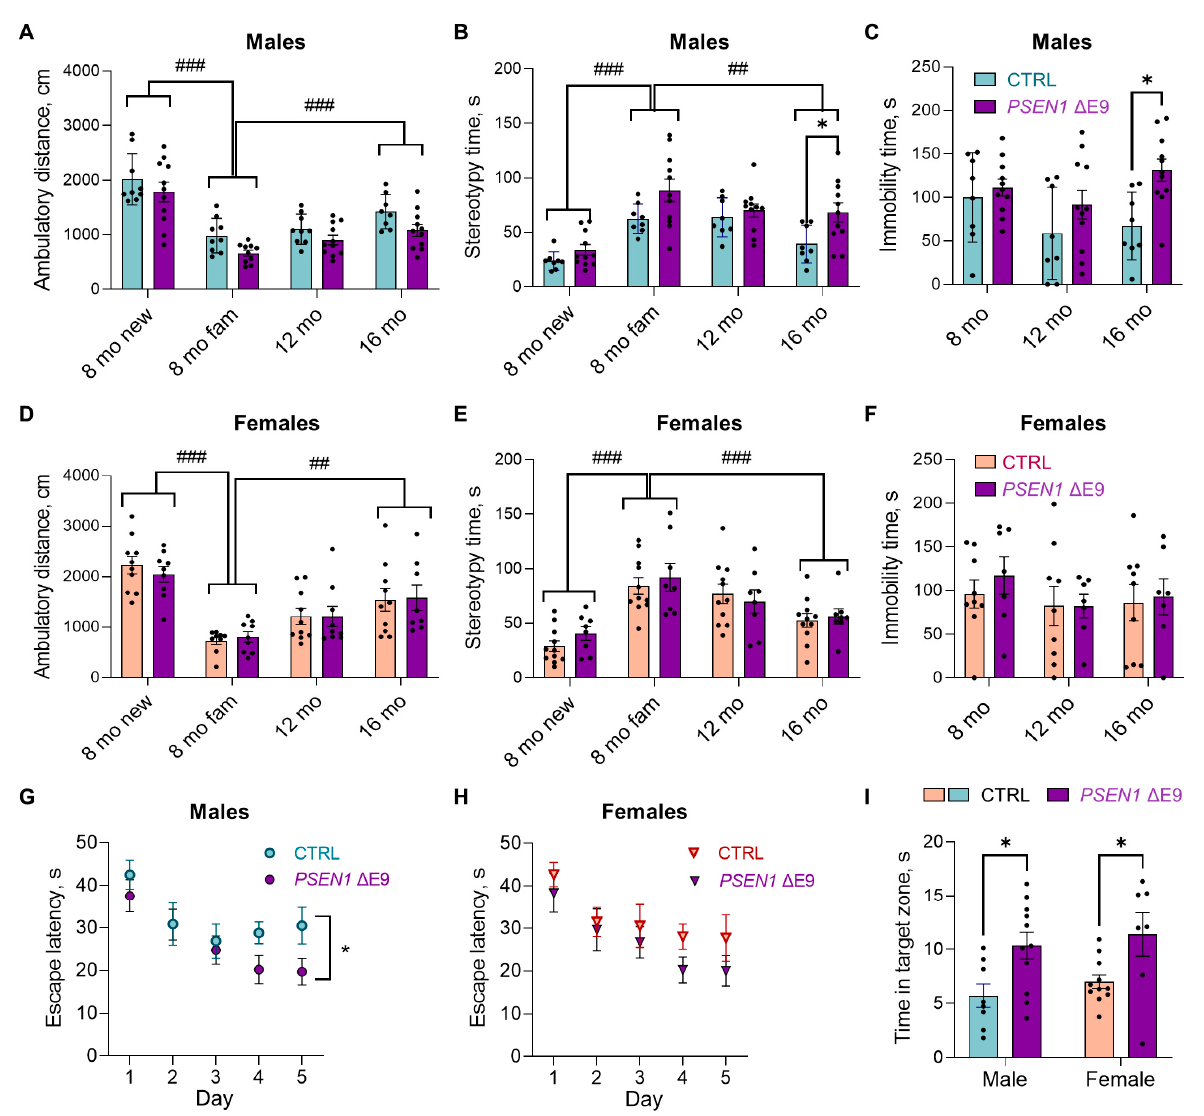
Figure 2. PSEN1 ∆ E9 mutation in human glial progenitors induced behavioral changes in 16-month- old mice. ( A , B , D , E ) Total distance traveled (cm) ( A , D ) and stereotypy time (s) ( B , E ) during a 10-min spontaneous exploration in the TruScan device at the ages of 8, 12, and 16 months in male ( A , B ) and female ( D , E ) mice. At the age of 8 months, the mice were exposed to the TruScan environment twice: first when it was a completely new environment (8-month new) and second when it was already a familiar environment (8-month fam). Purple bars indicate PSEN1 Δ E9 glia-transplanted mice, blue bars indicate CTRL-transplanted males, and salmon CTRL-transplanted females; dots represent values obtained from individual animals. ( C , F ) Immobility (floating) time (s) recorded during the last 4 min of a 6-min forced swim test. ( G , H ) Escape latency (s) to the submerged platform in Morris swim task (watermaze). ( I ) Time spent at the former platform position in the 2nd probe trial of Morris swim task (s). The data in the graphs are shown as mean ± SEM; n = 8–11 per group; * p < 0.05 as compared to sex- and age-matched CTRL; ## p < 0.01, ### p < 0.001.